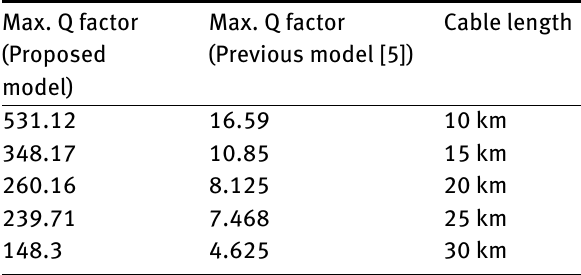
Figure 6: Results of the eye diagram analyzer with the directly modulated laser source along a cable length of 25 km. Table 2: Max. Q-factor dependence on cable